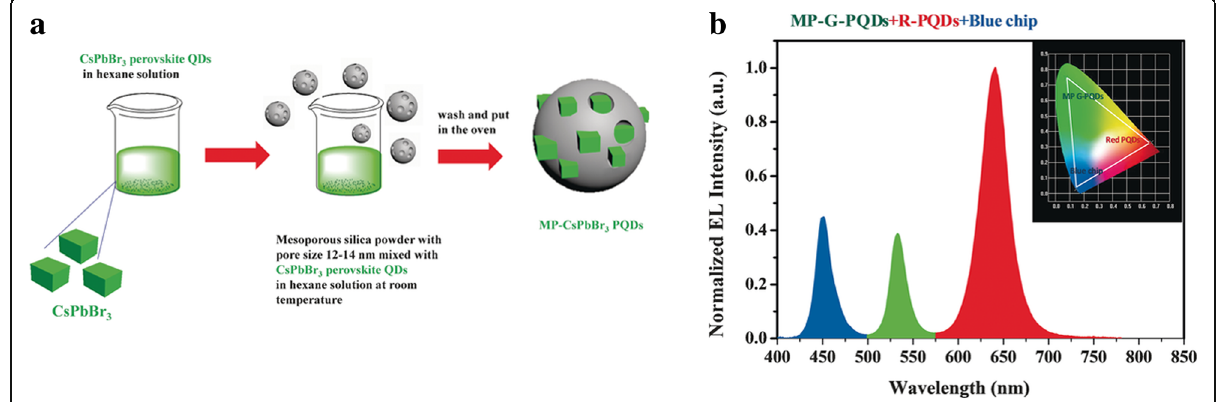
Fig. 17 a The formation progress of MP-CsPbBr3PQDs. b The luminescence intensity and the color triangle of WLED [35]